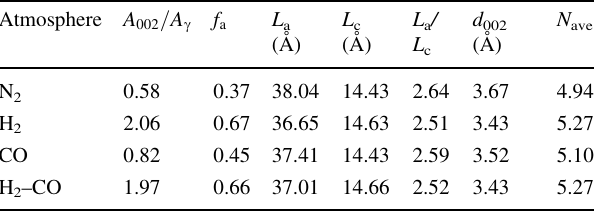
Table 5 Derived structure parameters extracted from curve-fitting of XRD of 700 (cid:3) C